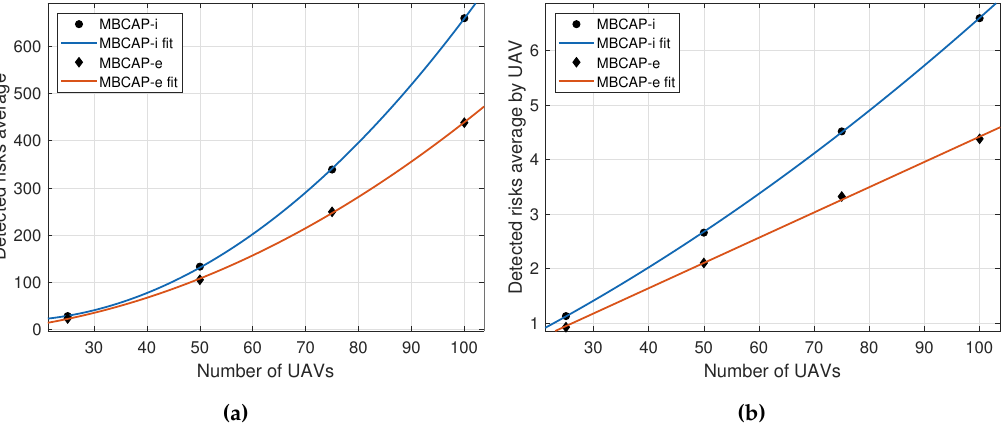
Figure 16. MBCAP-i vs. MBCAP-e: Average risks detected during an experiment. ( a ) Total risks vs. number of UAVs: O ( n 2 ) . ( b ) Risks by UAV vs. number of UAVs: O ( n )